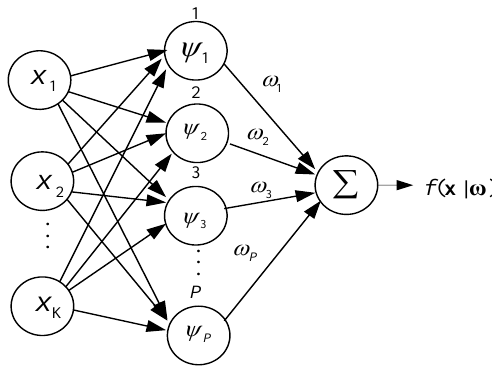
Figure 1. Framework of an regularized minimal-energy tensor-product spline.